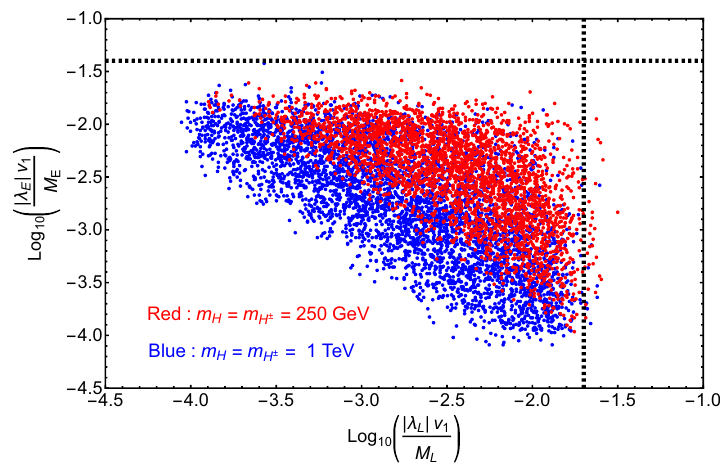
Figure 3 . The parameter space in the λ L − λ E plane which can explain the δa e anomaly at 2 σ . All the other parameters are varied as shown in table 2. The black dashed lines are constraints coming from Z pole